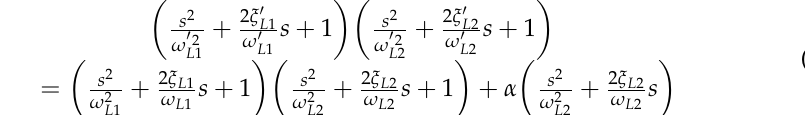
Figure 6. The condensed control block diagram of the thrust vector dynamics.